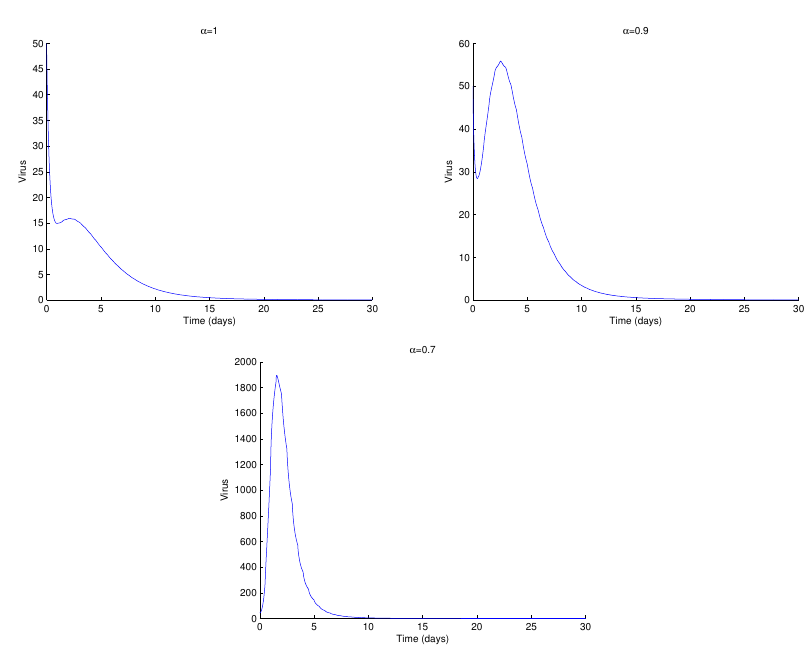
Figure 5. HIV viral-load, V , of the system (1) for α = 1 ( top left ), α = 0.9 ( top right ) and α = 0.7 ( bottom ). Parameter values and initial conditions in the text, except R k = 5.